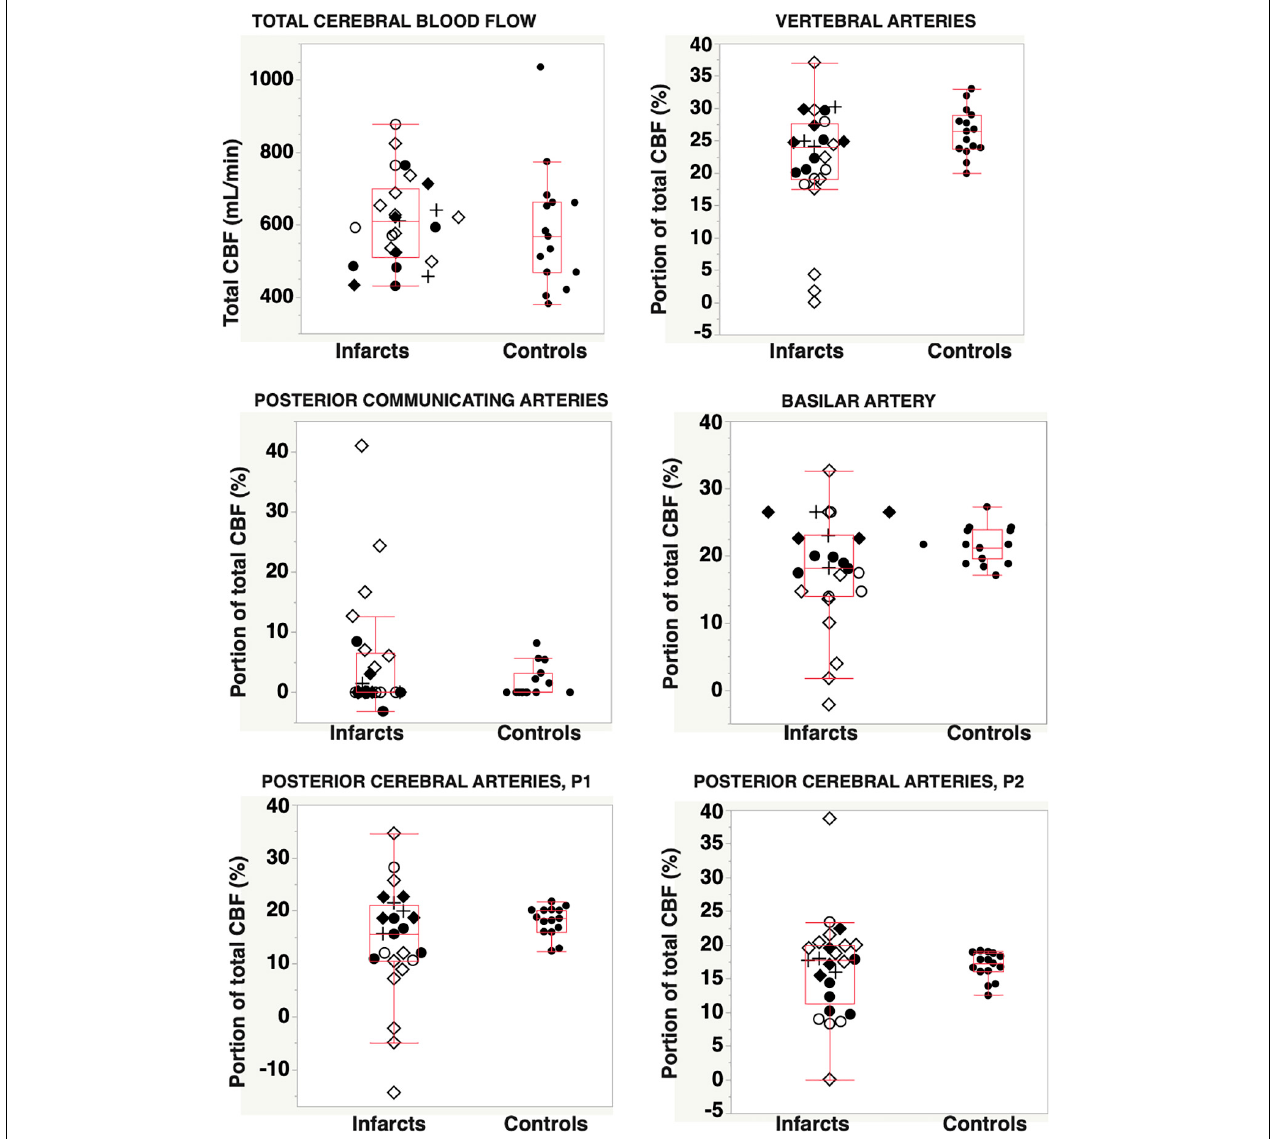
FIGURE 2 | Total cerebral blood flow and distribution of total CBF into the posterior circulation vascular tree, for patients with posterior circulation infarcts ( n = 25) and for controls ( n = 15). Abbreviations: (cid:5) , infarction in the proximal/middle territory and CTA-verified occlusion or stenosis of VA and/or BA; (cid:7) , infarct located in the proximal/middle territory, but without angiography findings in VA or BA; , infarction in the distal territory and CTA verified occlusion or stenosis in the PCA; located in the proximal/middle territory, without angiography findings in the PCA; and +, brain stem infarcts classified as proximal/middle territory infarcts and without (cid:35) corresponding CTA findings. CBF, cerebral blood flow; CTA, computed tomography angiography; VA, vertebral arteries; BA, basilar artery; PCA, posterior cerebral